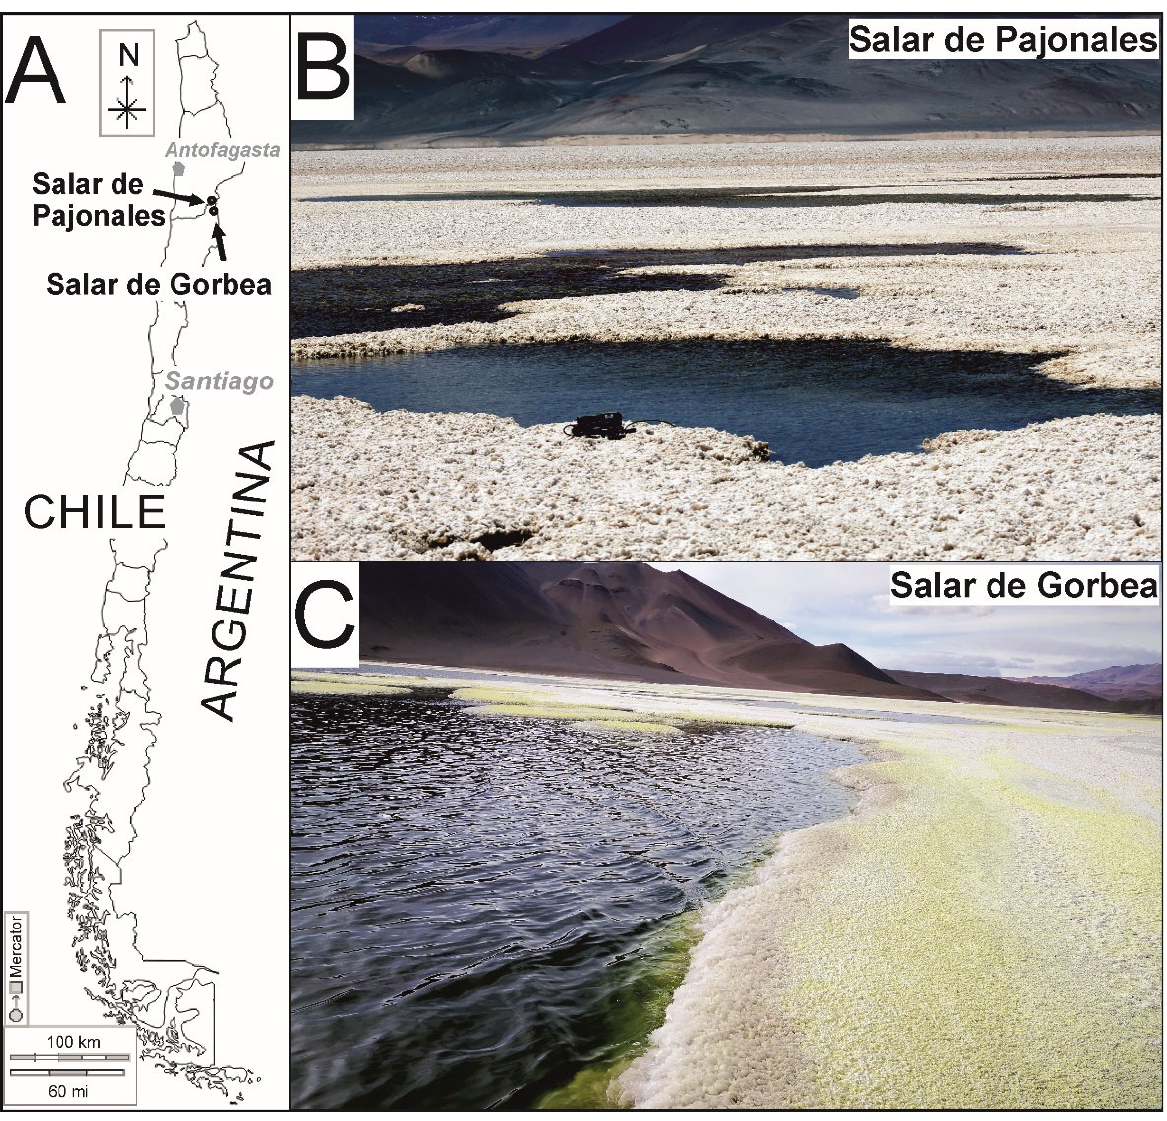
Figure 1. ( A ) Location of the sampling sites in Chile. Overview images of the salt flat ponds in Salar de Pajonales ( B ) and Salar de Gorbea ( C ). Note: white and yellow mineral crusts are comprised mainly by gypsum and halite in ( B ) [23,37,40] and gypsum mixed with Al-Mg and K-Fe sulphates in ( C ) [38].